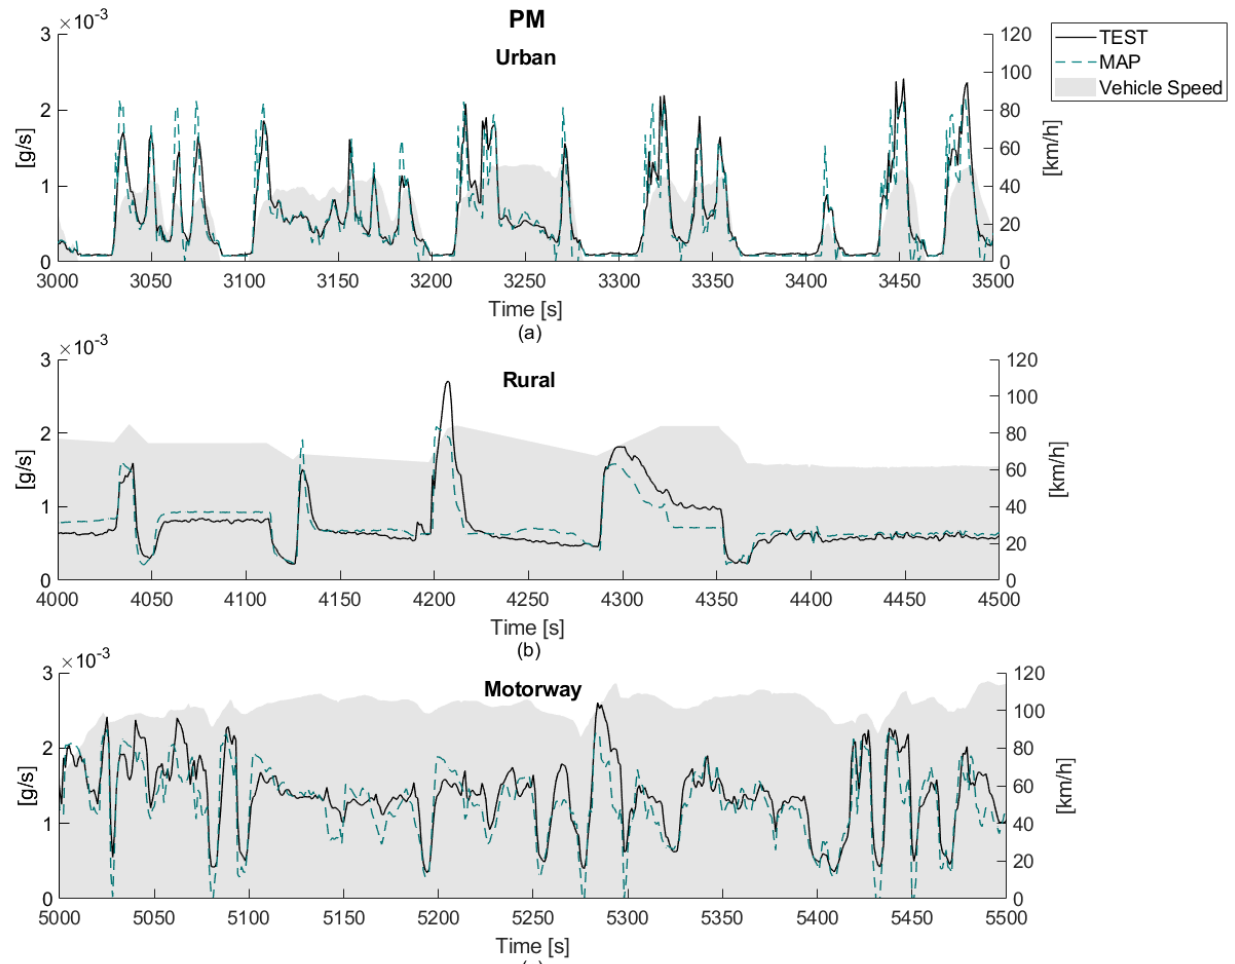
Figure 15. RDE 1 periods PM urban ( a ), rural ( b ) and motorway ( c ) mass emissions [g/s] test versus engine map.